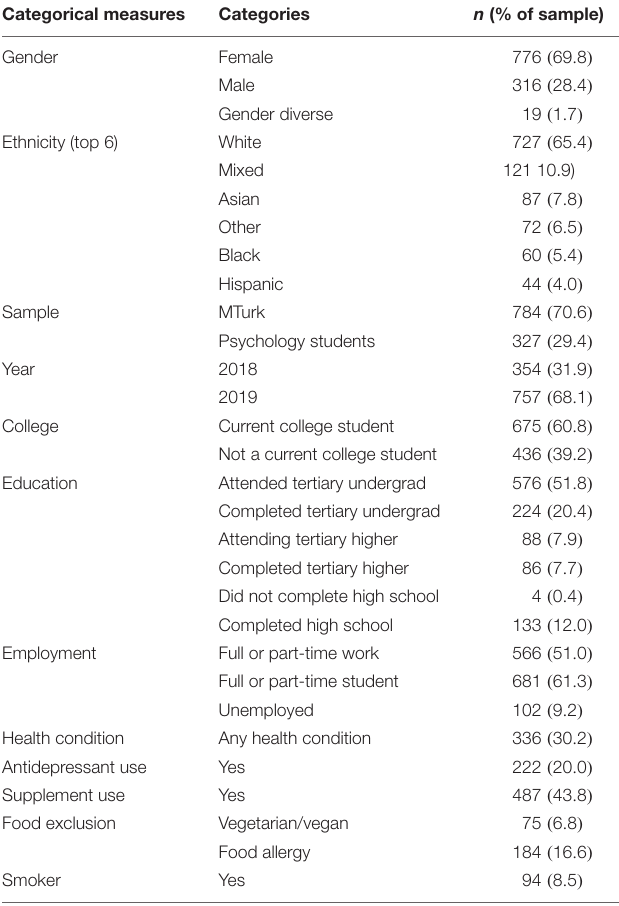
TABLE 1 | Descriptive statistics for categorical participant